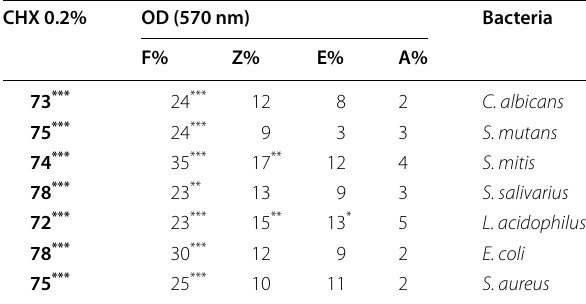
Table 6 The biofilm reduction percentage of species treated with samples of A, E, Z, F, and chlorhexidine